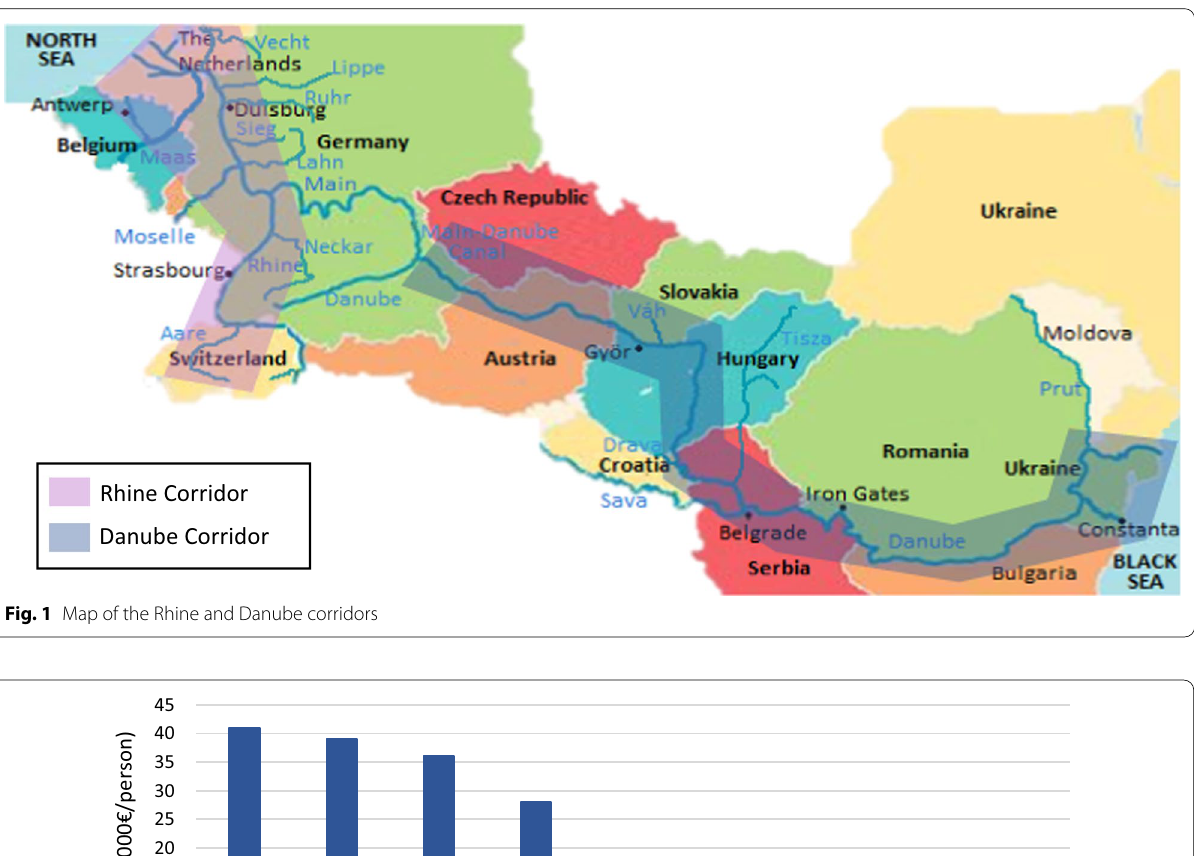
Fig. 2 Average annual personnel cost per person (2016). Source : (1) CCNR, 2019 (2) *statistical Office of the Republic of Serbia 2019